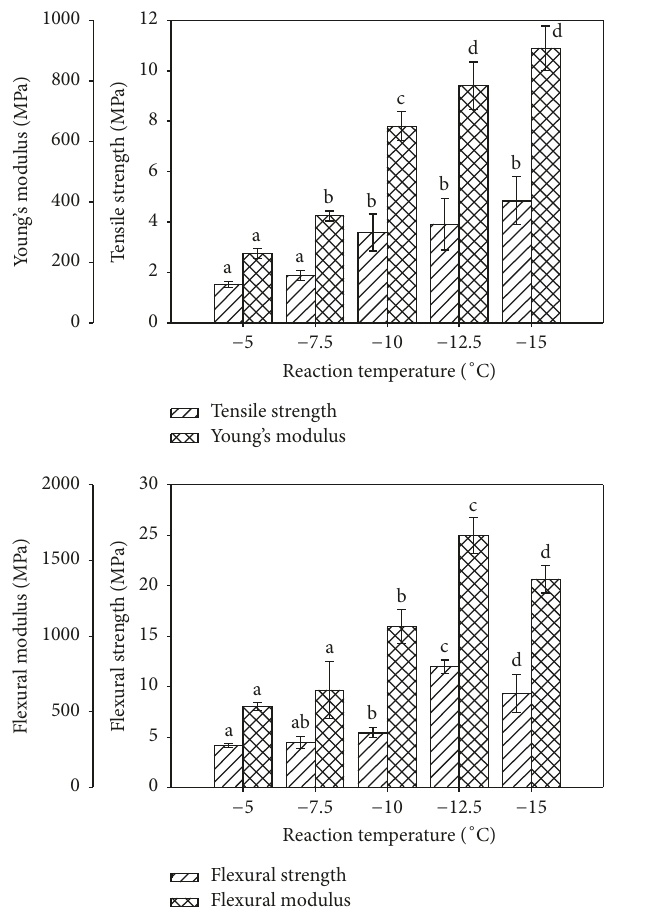
Figure 3: Influence of cotton matrix concentration on the mechan- ical properties of biocomposites composed of 25% cotton: 75% OOW/AF. Treatment values with different letters for the same mechanical test are significantly different ( 𝑝 ≤ 0.05 ) following Duncan’s Multiple Range Test